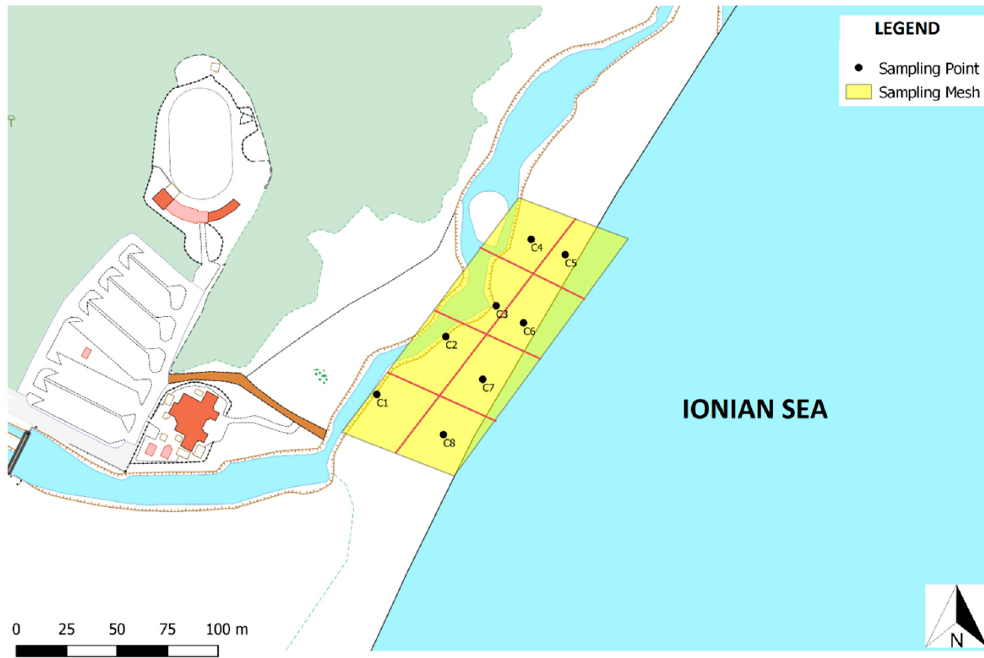
Figure 4. Location of sampling points: Sampling mesh. Table 1. Geographical coordinates of the sampling points (UTM